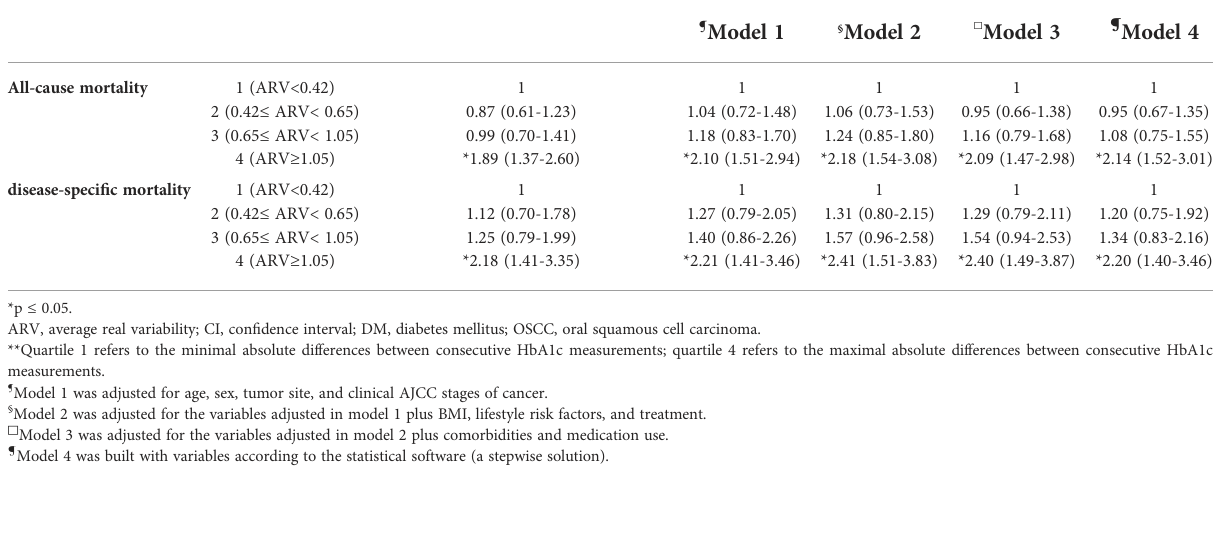
TABLE 3 Modeling for the effects of ARV on all-cause mortality and disease-speci fi c mortality in OSCC patients with DM .